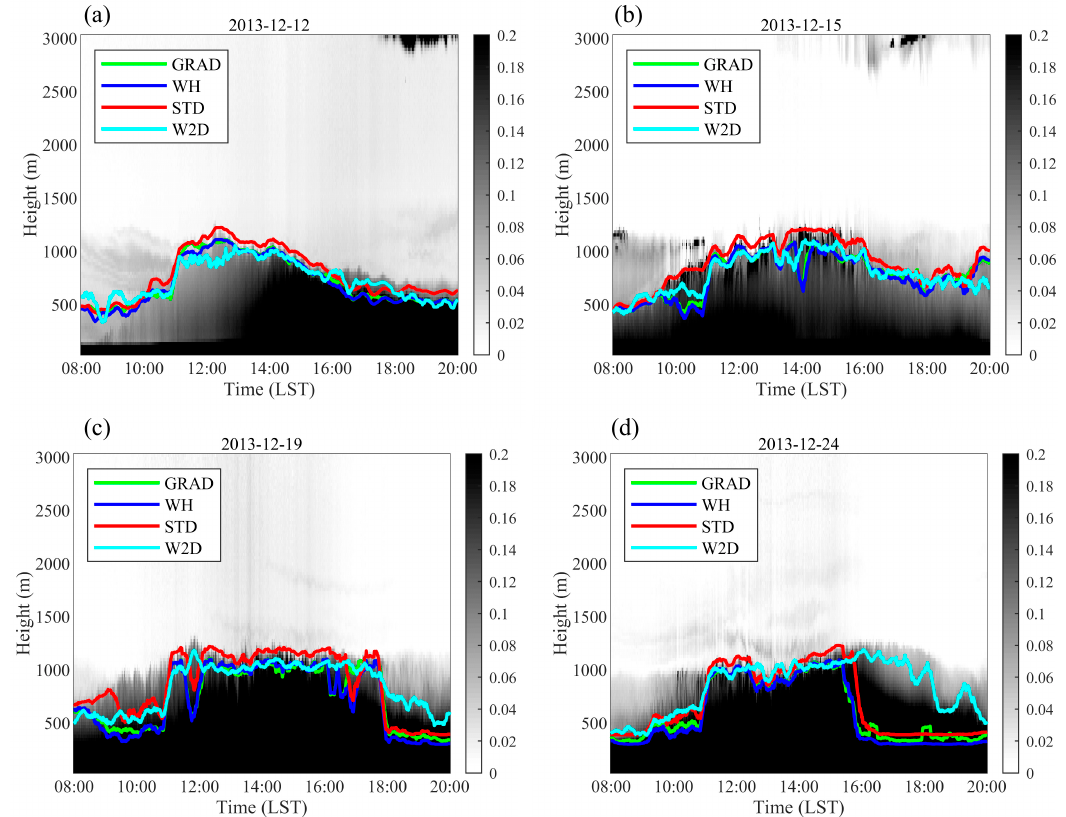
Figure 5. The diurnal variations of ML heights (solid lines) calculated by the 2D wavelet method based on different wavelet filters: ( a ) December 12, ( b ) December 15, ( c ) December 19, and ( d ) December 24, 2013. The influences of cumulus on the lidar observations is also shown in (c). The grey shades show the extinct coefficients, unit: hm − 1 .